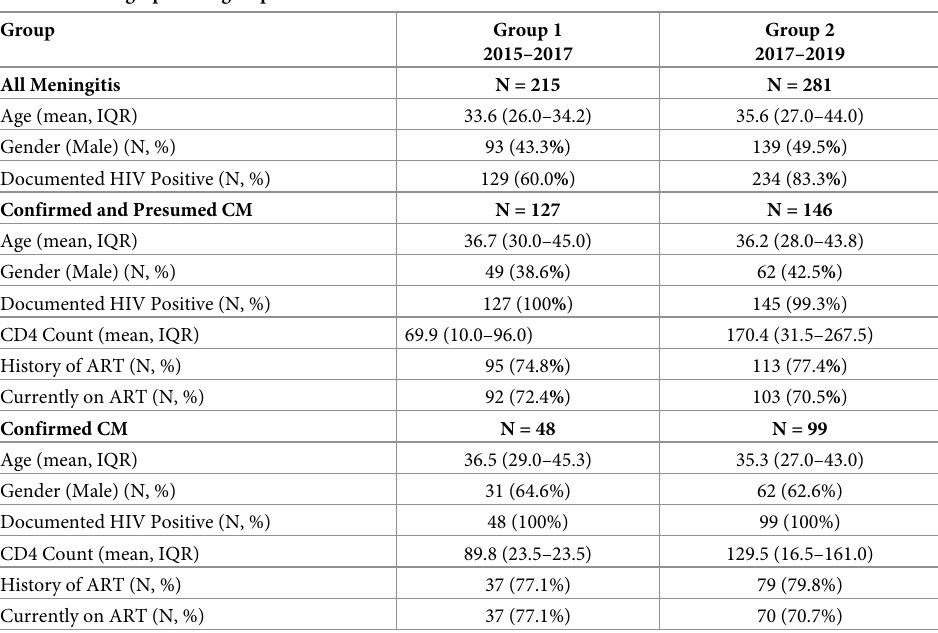
Table 1. Demographics of groups 1 &